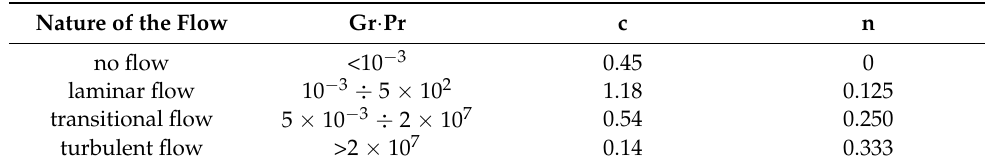
Table 1. Values of geometric constants c and n